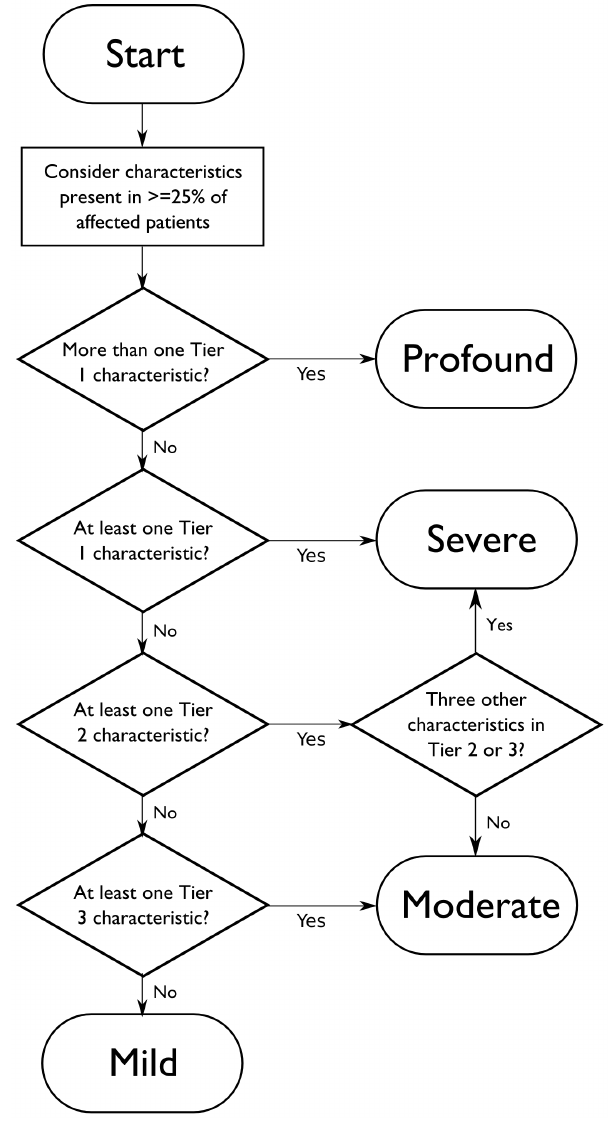
Fig. 4. Proposed decision algorithm for severity